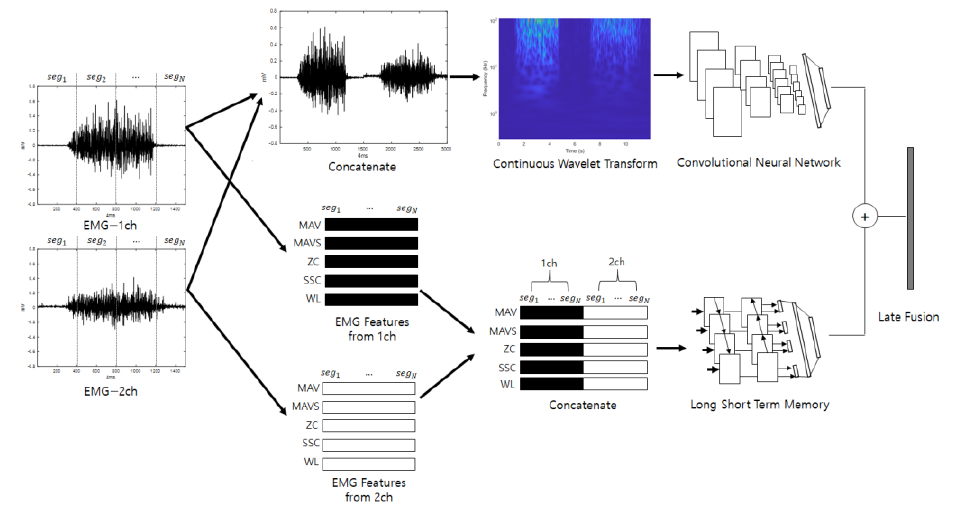
Figure 3. Ensemble deep learning-based individual identification system that uses EMG (EmgEn-